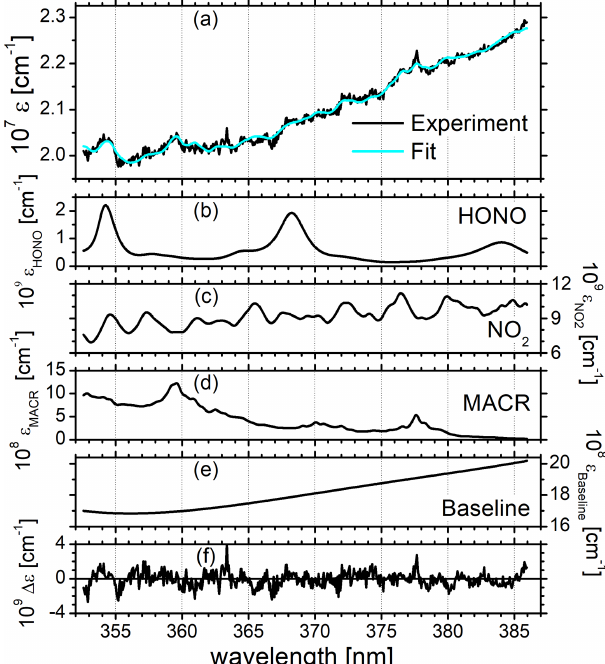
Figure 1. Example of the extinction coefficient spectrum, ε(λ) , measured with IBBCEAS at SAPHIR in the wavelength range 352– 386nm with an integration time of 1min, taken at 13:00UTC on 11 July 2011. (a) Measured extinction (black), fit of Eq. (1) to the extinction (cyan). (f) Absolute fit residuals (cid:49)ε = ε fit − ε exp . HONO, NO 2 , and MACR mixing ratios were retrieved as n HONO = = 0 . 586ppbv, and n = 8 . 055ppbv, respec- 0 . 160ppbv, n NO MACR 2 tively. The corresponding contributions and the polynomial base- line are shown in panels (b) , (c) , (d) , and (e) . The absolute wave- length scale was calibrated with a low-pressure Ne pen ray lamp (see Fig. S9). No O 2 –O 2 absorption at ∼ 360 and ∼ 380nm is ob- served since all spectra, I 0 (λ) and I(λ) , were measured in synthetic